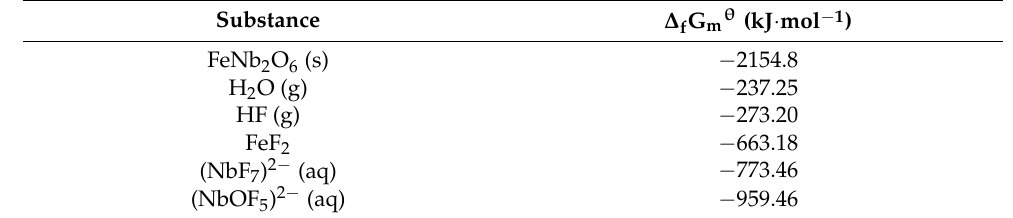
Table 5. Standard thermodynamic data of FeNb 2 O 6 , H 2 O, HF, FeF 2 , and (NbF 7 ) 2 − at 298 K, 100 kPa